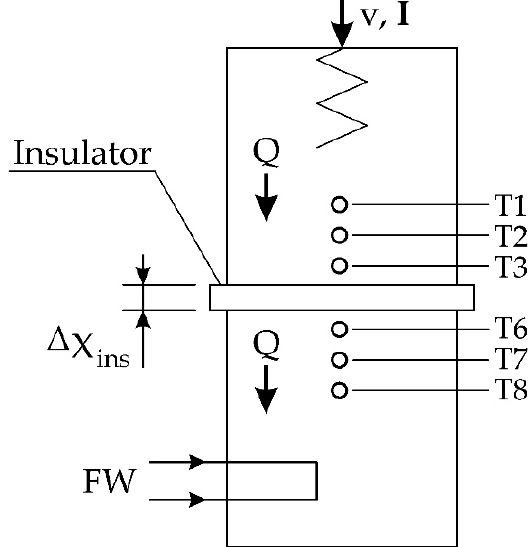
Figure 2. The application of poor conductors. Where: T (1,2,3,6,7,8) thermocouple, ∆ x red or ∆ x ins is a thickness of measure sample, U is voltage, A—ampere, Q is heat flux, FW—flow of cooling water. The heating section represented by thermocouple T1, T2, and T3 is manufactured from 25 mm diameter cylindrical brass bar with a cartridge type electric heating element installed at one end. The cooling section represented by thermocouple T6, T7, and T8 is manufactured from 25 mm diameter cylindrical brass bar to match the heating section and cooled at one end by water (FW) passing through galleries in the section. The heated and cooled sections are clamped tightly together with the poor conductors in between to create a composite bar with the insulated disk of unknown thermal conductivity sandwiched between two brass sections. The theoretical temperature distribution in cross-sections is shown in Figure 3. Figure 3. Theoretical temperature distribution in cross-sections. Where: X—length of the sections [m] , A—is a cross-section [m 2 ], T (1,3,6,8)—temperature at measure points, 𝑇 (cid:3035)(cid:3042)(cid:3047)(cid:3033)(cid:3028)(cid:3030)(cid:3032) , 𝑇 (cid:3030)(cid:3042)(cid:3039)(cid:3031)(cid:3033)(cid:3028)(cid:3030)(cid:3032) —cal- culated temperature at boundary of the layer. Insulators have very low values of thermal conductivity which means that only a small amount of heat will pass through the material even though a high temperature dif- ference may exist across its two faces. Because of the low value of k for an insulator, the dimension x must be small [42]. The heat flow is calculated from the temperature gradient for the hot (9) and cold (10) parts. This is possible thanks to the known thermal conduc- tivity of the heater and cooler, as well as the position of the thermocouples and the tem- perature value. Heat flow of heater calculated from Equation (9) [42]: